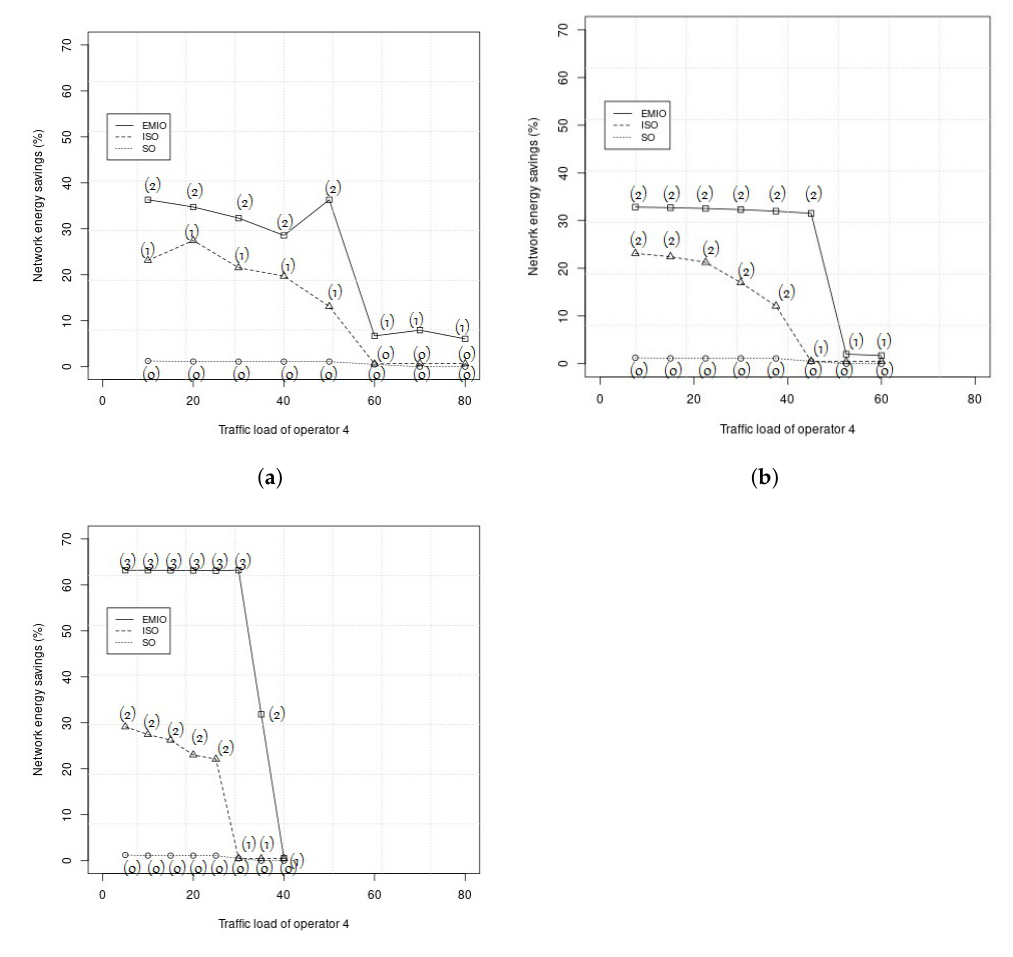
Figure 7. Network energy savings. ( a ) Scenario 1—High traffic; ( b ) Scenario 2—Medium traffic; ( c ) Scenario 3—Low